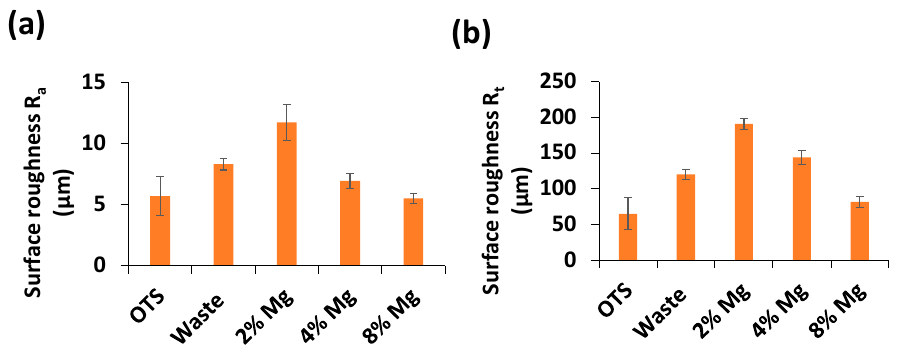
Figure 11. Comparison of surface roughness ( a ) R a and ( b ) R t for different prints.